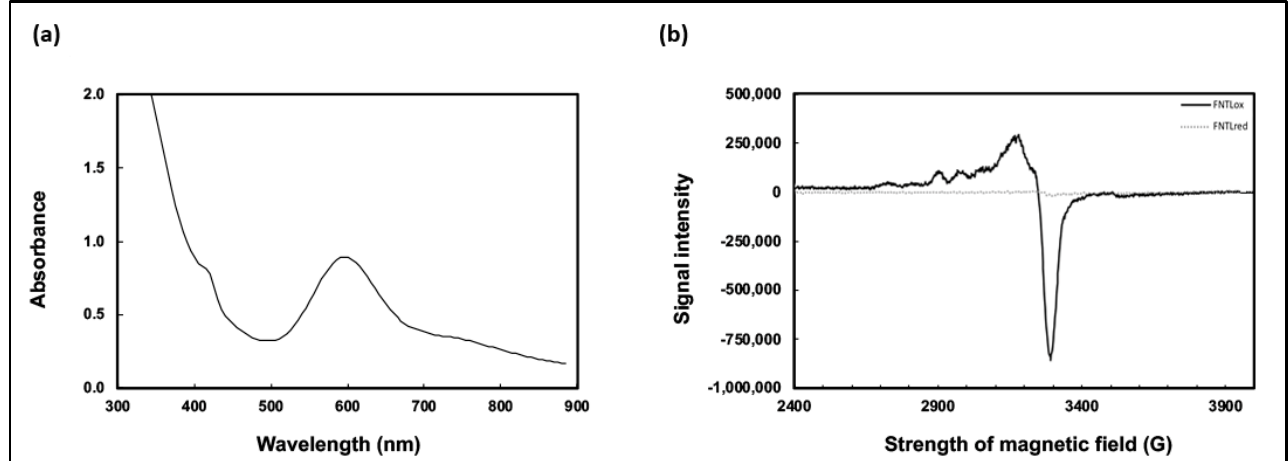
Figure 1. ( a ) UV-visible absorption spectrum of puri fi ed FTNL. ( b ) EPR spectrum of the puri fi ed ( a ) UV-visible absorption spectrum of purified FTNL. ( b ) EPR spectrum of the laccase . purified